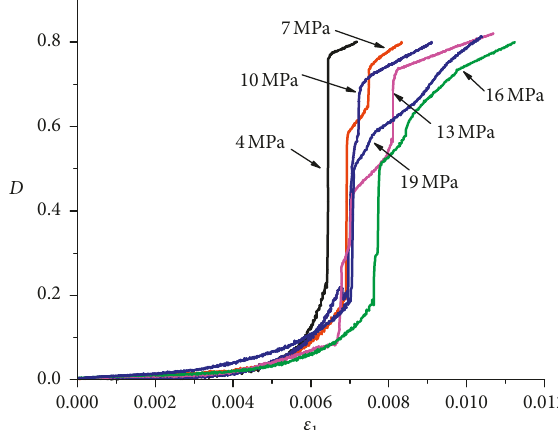
Figure 10: Damage curves of rock samples under conventional triaxial compression based on the dissipation